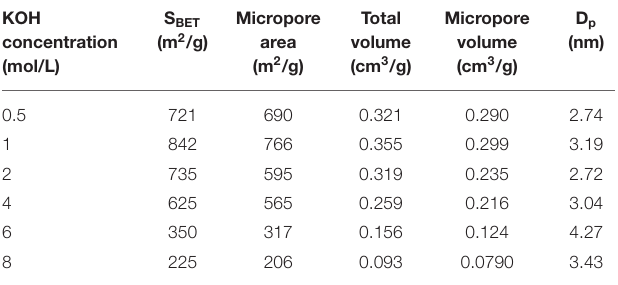
TABLE 4 | BET results for LACFP using different KOH concentrations. TABLE 5 | Physical parameters of sisal hemp paper before and after